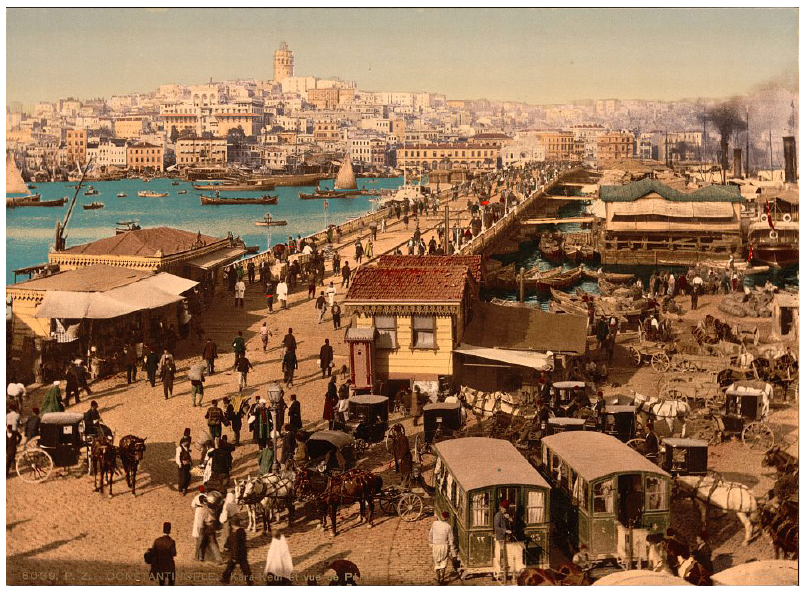
FIG. 3 Postcard showing the busy port district Karakeui and Galata Bridge that spans the Golden Horn in Constantinople. The bridge is the third construction that was built by the French company Forges et Chantiers de la Mediteranée in 1875 and used until 1912 16 , ©Library of